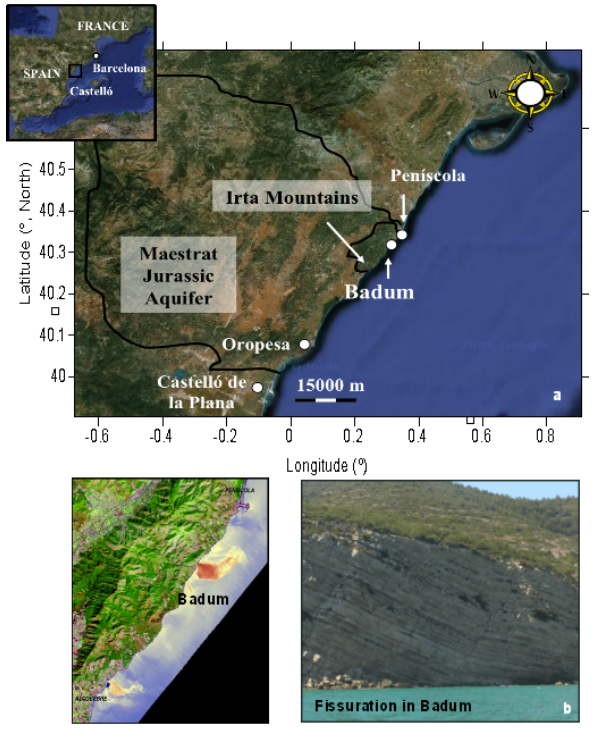
Fig. 1. (a) Location map of the Badum coastal area, which resides 762 inside a natural protected region ( Irta Mountains). The extension of the main carbonate Maestrat aquifer is also delimited.). (b) Thermal infrared image of the area taken on June 2006 (from Ant´on-Pacheco et al., 2007) (left) and (b) a picture of the Badum coastal area show- ing the rock fissuration of the karstified Maestrat aquifer that allows coastal springs to occur